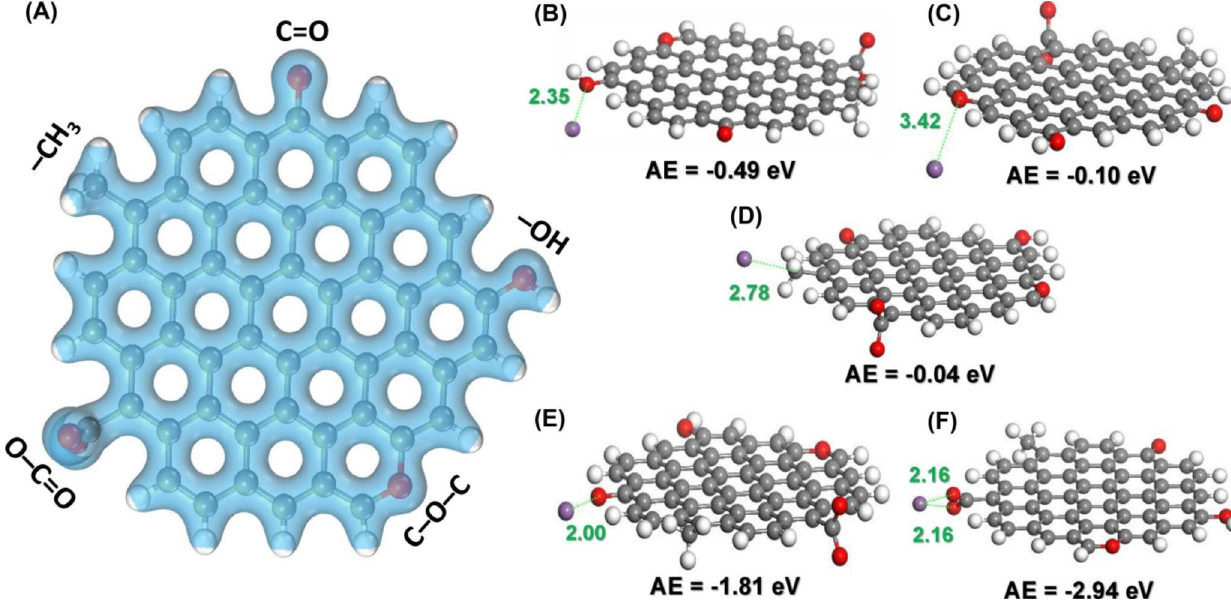
Fig. 8 DFT calculations of Sb(III) adsorption. Basic framework of carbon substrate with five functional groups (–OH, C–O–C, –CH O = C–O) (A); and fully optimized geometries and adsorption energy (AE) with Sb(III) adsorbed by –OH (B); C–O–C (C); –CH 3 (D), C = O (E), and O = C–O (F). Sb, C, O and H are shown as purple, grey, red and white balls, respectively. Electron density is shown with transparent blue isosurface in (A) with an isovalue of 0.5 e/Å 3 . Sb-O distance (green lines) in (B)-(F) is labelled in unit of